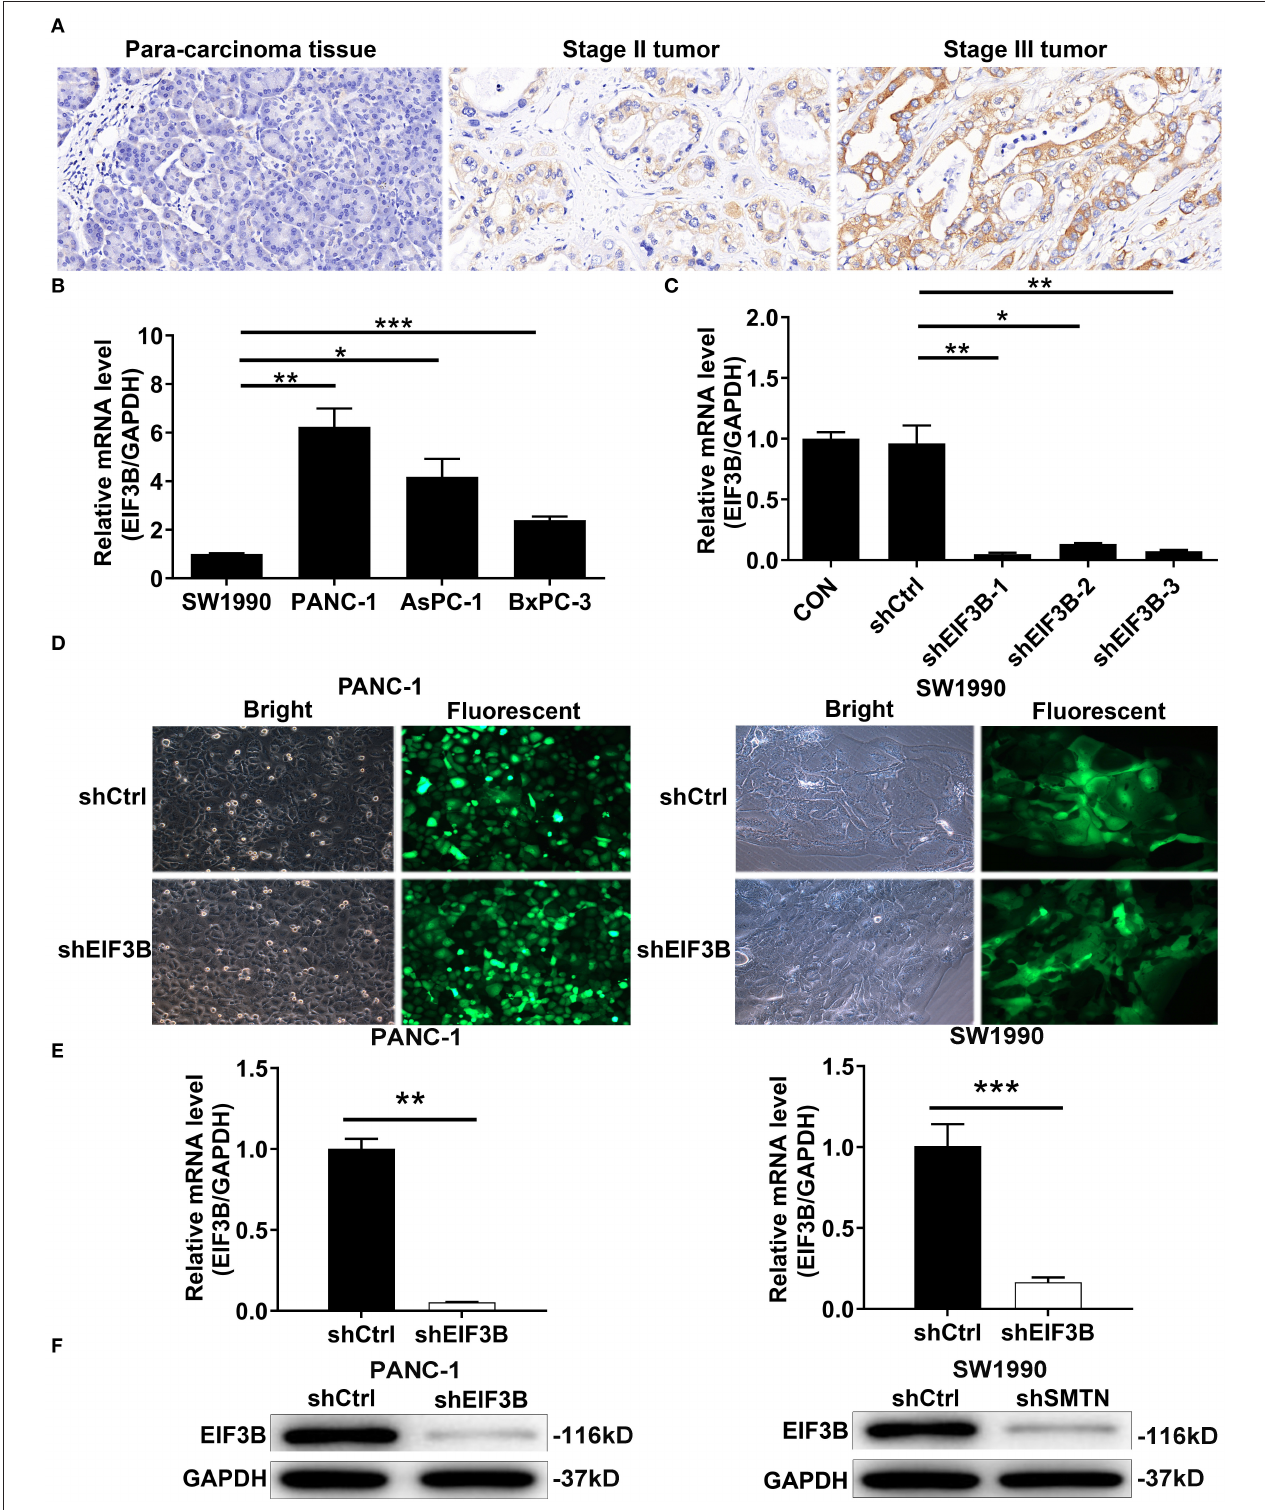
FIGURE 1 | Eukaryotic translation initiation factor 3 subunit B (EIF3B) was up-regulated in pancreatic cancer (PC) and EIF3B knockdown cell model was constructed. (A) The expression levels of EIF3B in PC tumor tissues and para-carcinoma tissues were determined by immunohistochemical staining. Magnification times: 200 ×